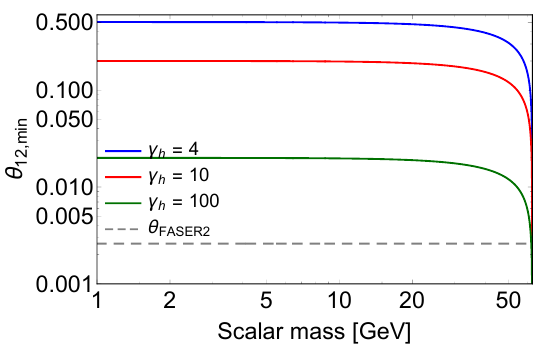
Figure 10 . The minimal angle (B.9) between two scalars produced in the decay H ! SS versus the scalar mass m S for particular values of the (cid:13) factor of the Higgs